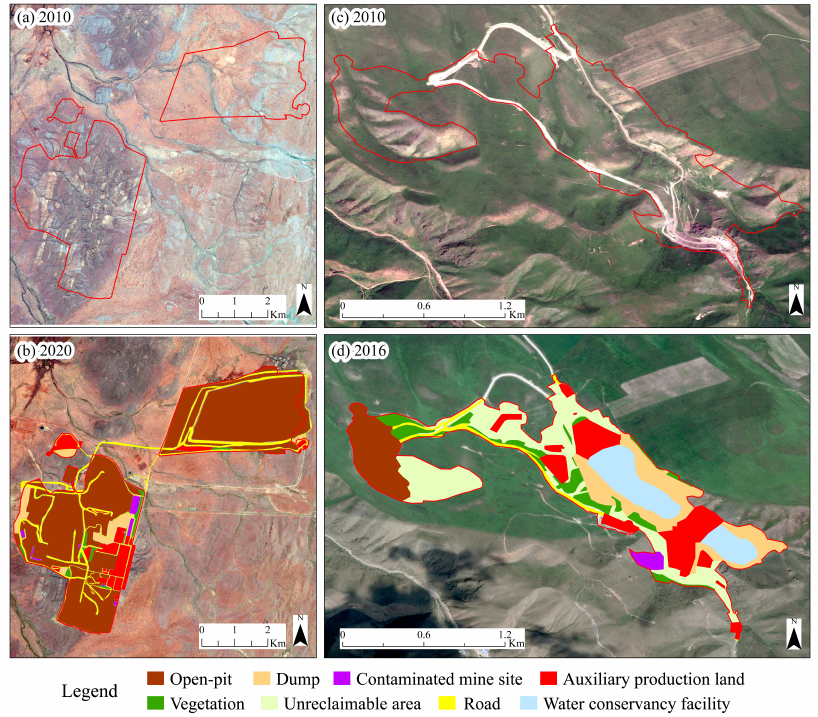
Figure 2. The visual interpretation results in different periods ( a , b ) for Sino Iron and ( c , d ) for Taldybulak Levoberezhny.